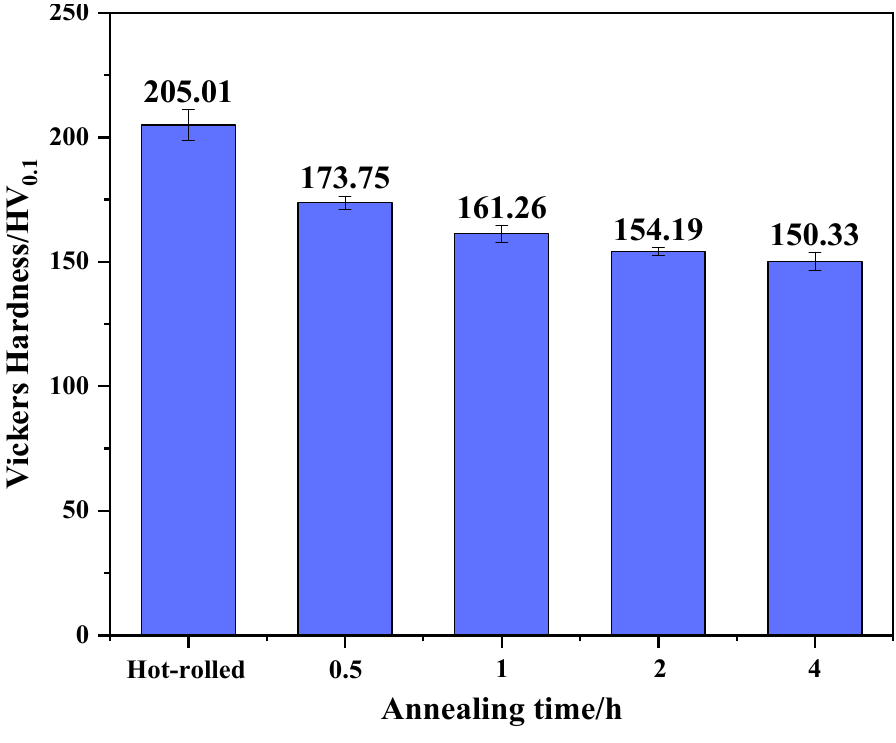
Figure 10. Vickers hardness of TA10 alloy.